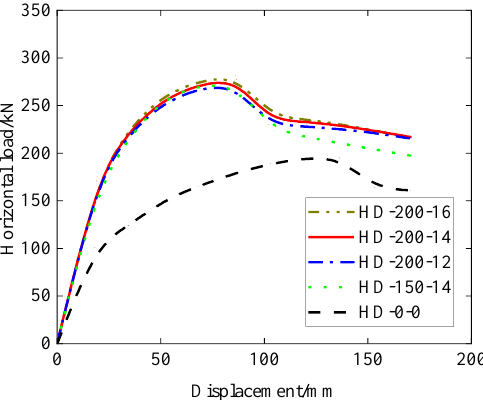
Table 4. Analysis parameters and calculation results of haunch height and reinforcement.